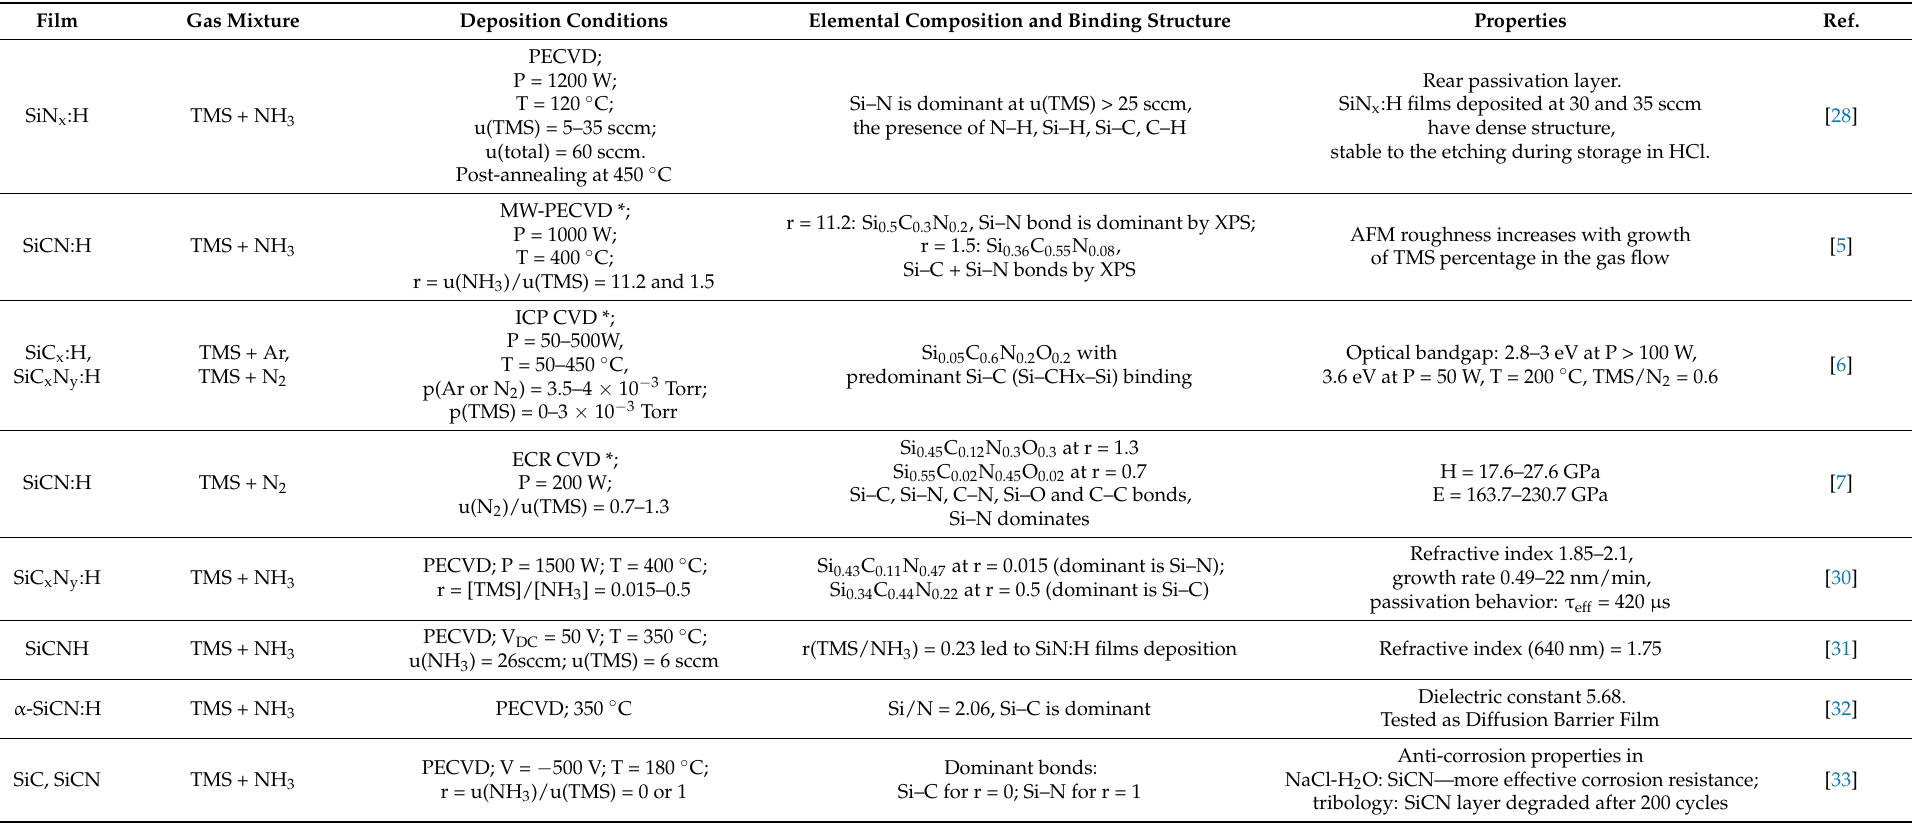
Table 1. The literature data on Si–C–N films synthesis and characterization using TMS as a